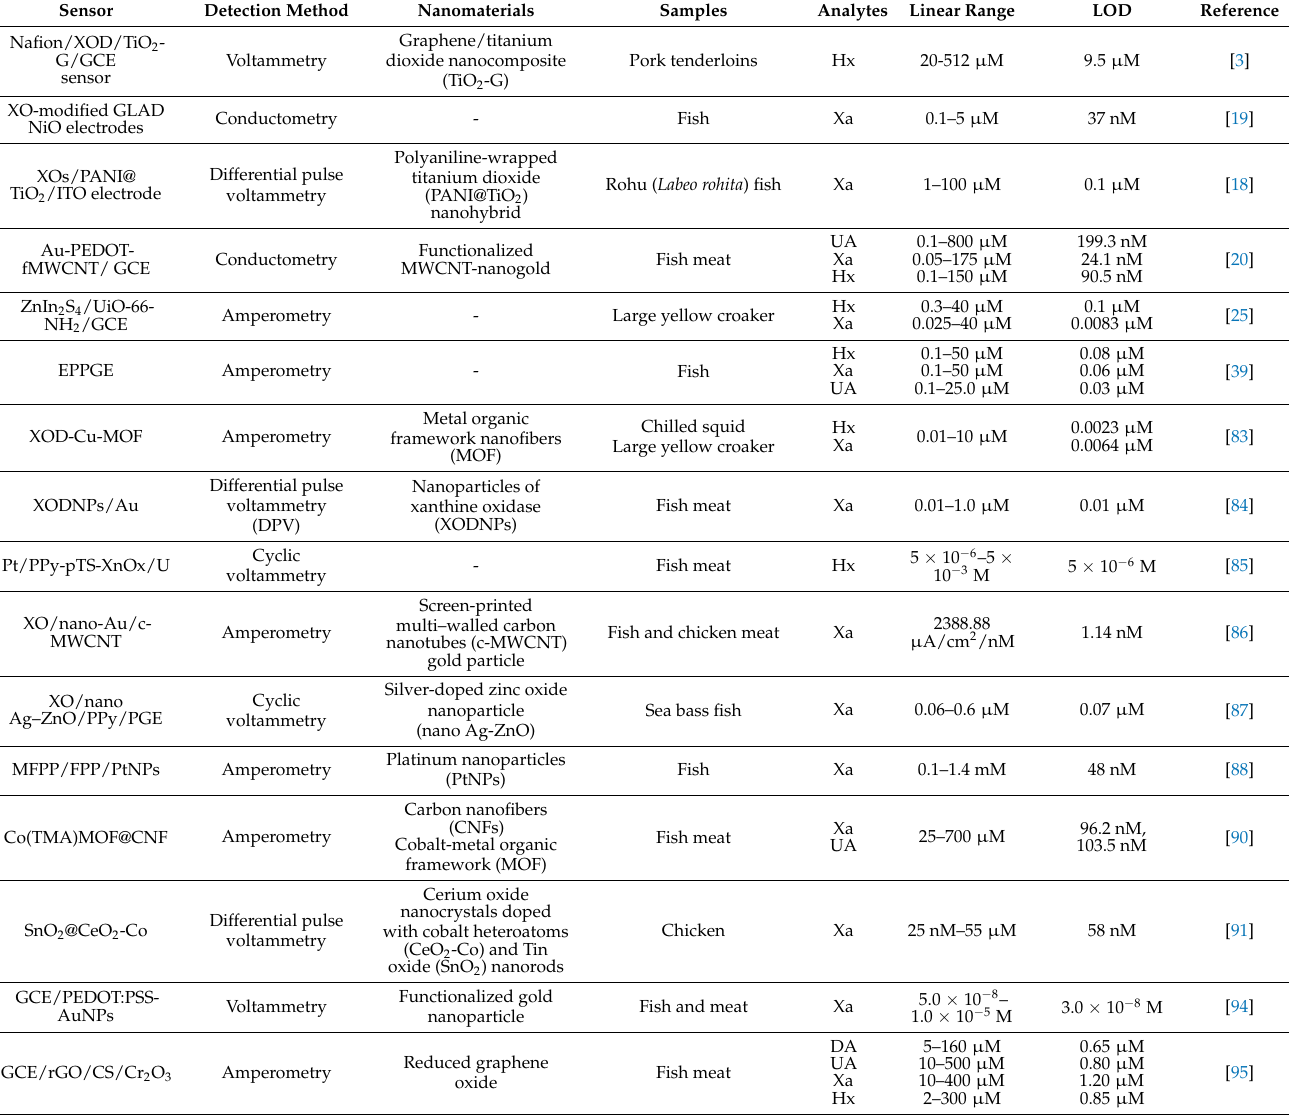
Table 2. Recent trends of electrochemical biosensors in detecting meat freshness and their analytical performance in food